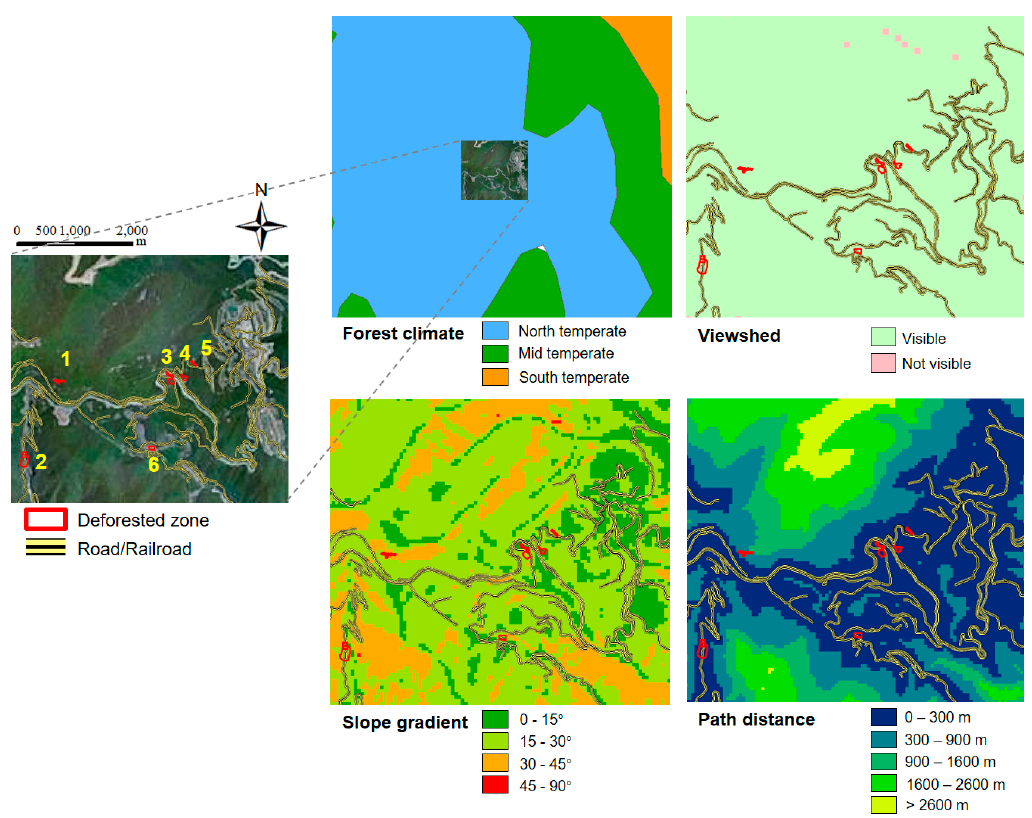
Figure 8. GIS-based reforestation planning for deforested areas using forest climate map, viewshed analysis map, slope analysis map, and path distance map (modified from Kim et al. [2]).